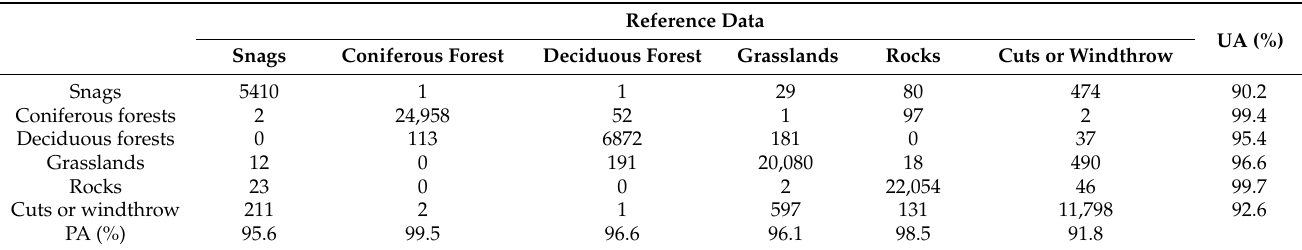
Table 4. Error matrix for the Tatra land cover classification based on the Sentinel-2 image (3 October 2015); overall accuracy 97%, Kappa coefficient 0.96. Explanation: UA—user accuracy; PA—producer accuracy.